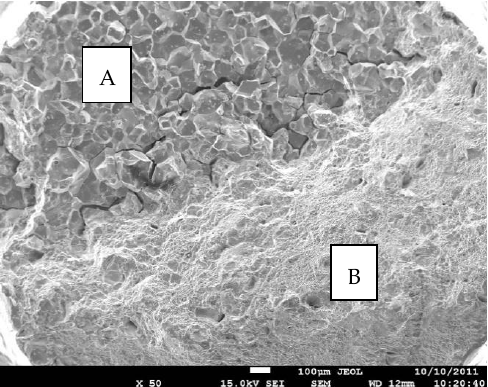
Figure 13. Fracture surface of crept VAT 36 sample, in creep test at 700 ◦ C and stress of 600 MPa, with intergranular (A) and transgranular ductile (B)